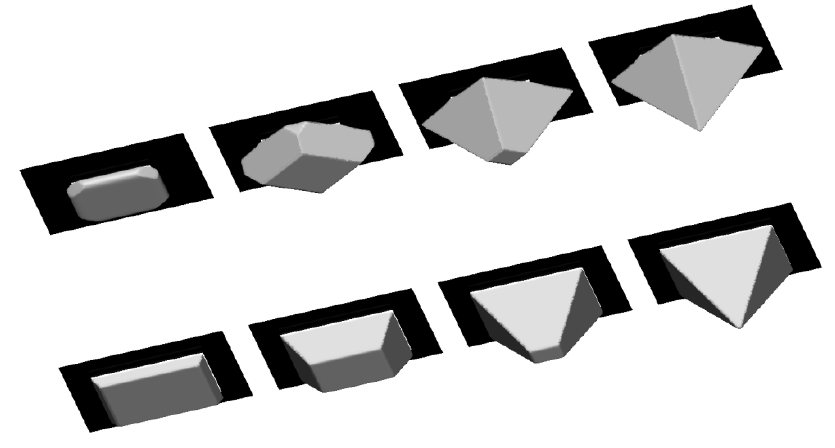
Figure 8. Etching through a square aperture mask in {100} plane aligned to <100> (upper row) and <110> (lower row) directions. Profiles after 100 s, 300 s, 600 s and 900 s, obtained using thirteen-parameter interpolation